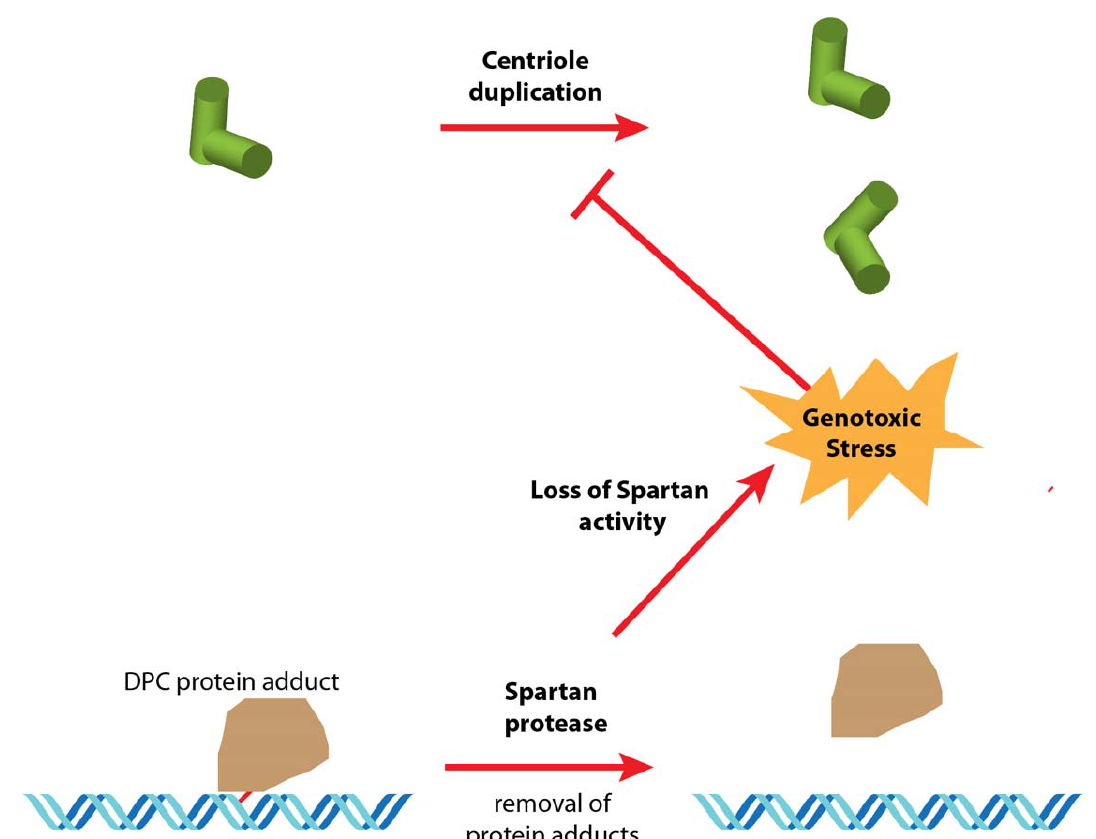
Figure 1. Hypothesis 1: loss of Spartan activity impacts centriole duplication in cell culture. In wild-type cells, the Spartan metalloprotease removes covalent DNA protein crosslinks (DPC), which can block the passage of the DNA replication complex. In mh 1 mutant cells, the lack of Spartan activity leads to the persistence of DPCs, possibly resulting in chronic DNA replication stress in these constantly dividing cells. This, in turn, induces a DNA damage response that could a ff ect either the centriole duplication cycle or even the centriole